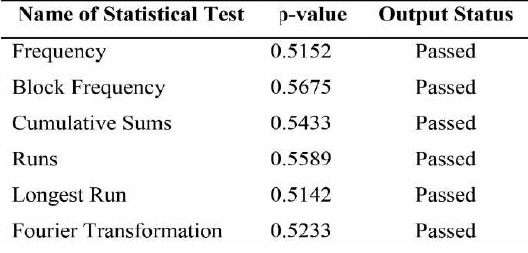
Figure 8. Findings of NIST statistical test.